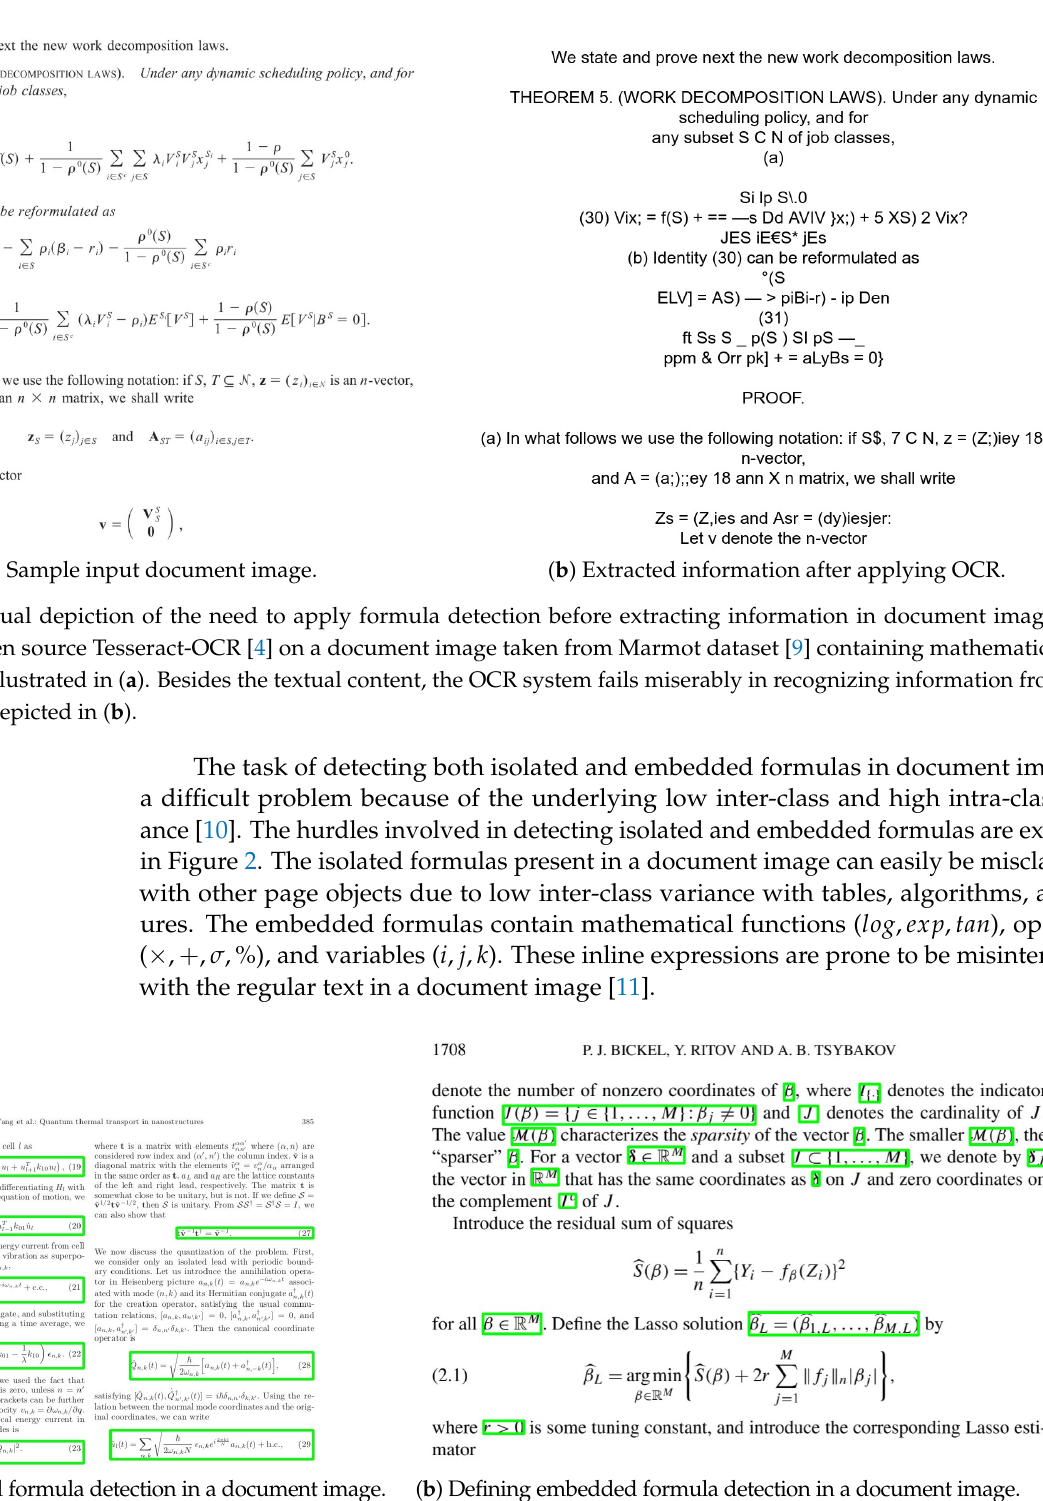
Figure 2. Instances of isolated and embedded formulas in sample document images. The green boundaries represent the ground truth regions. Separate images are used for the convenience of the readers. The isolated formulas highlighted in ( a ), spanning multiple lines, are prone to be misclassified with tables, whereas the embedded formulas depicted in ( b ) are confused with the regular